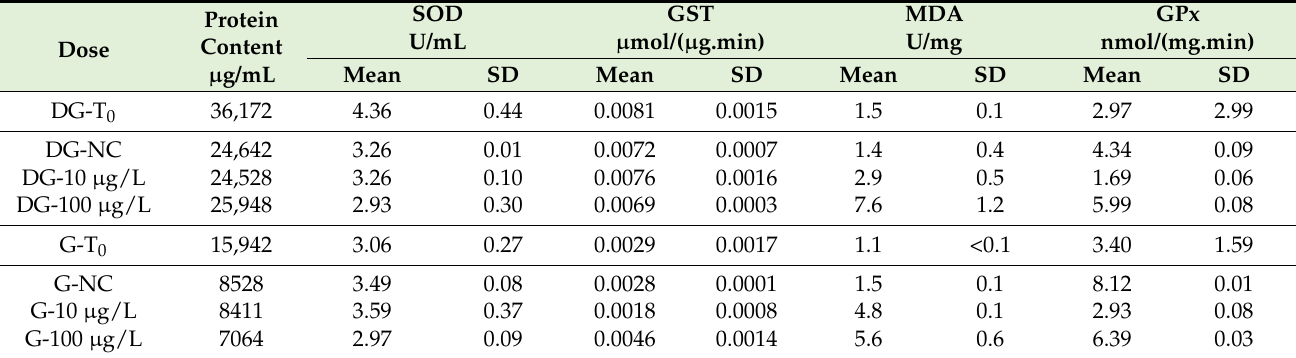
Table 3. Levels of biomarkers of oxidative stress in digestive gland (DG) and gills (G) of M.